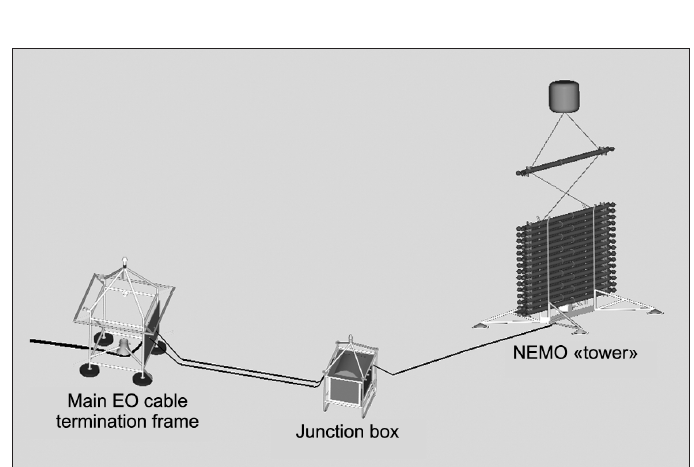
Fig. 5. Schematic layout of the NEMO Phase 1